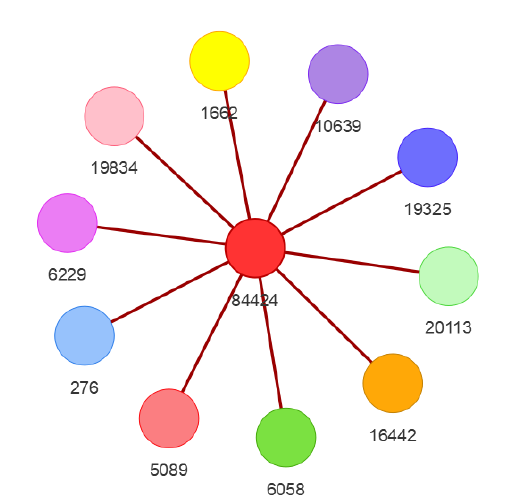
Figure 5. Example of Graph construction through edge